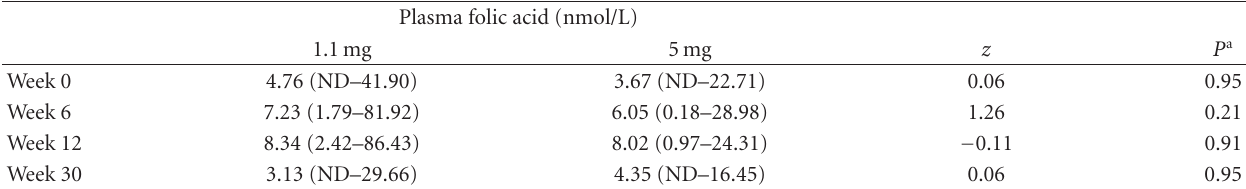
Table 5: Between-group comparisons of plasma concentrations of unmetabolized folic acid.